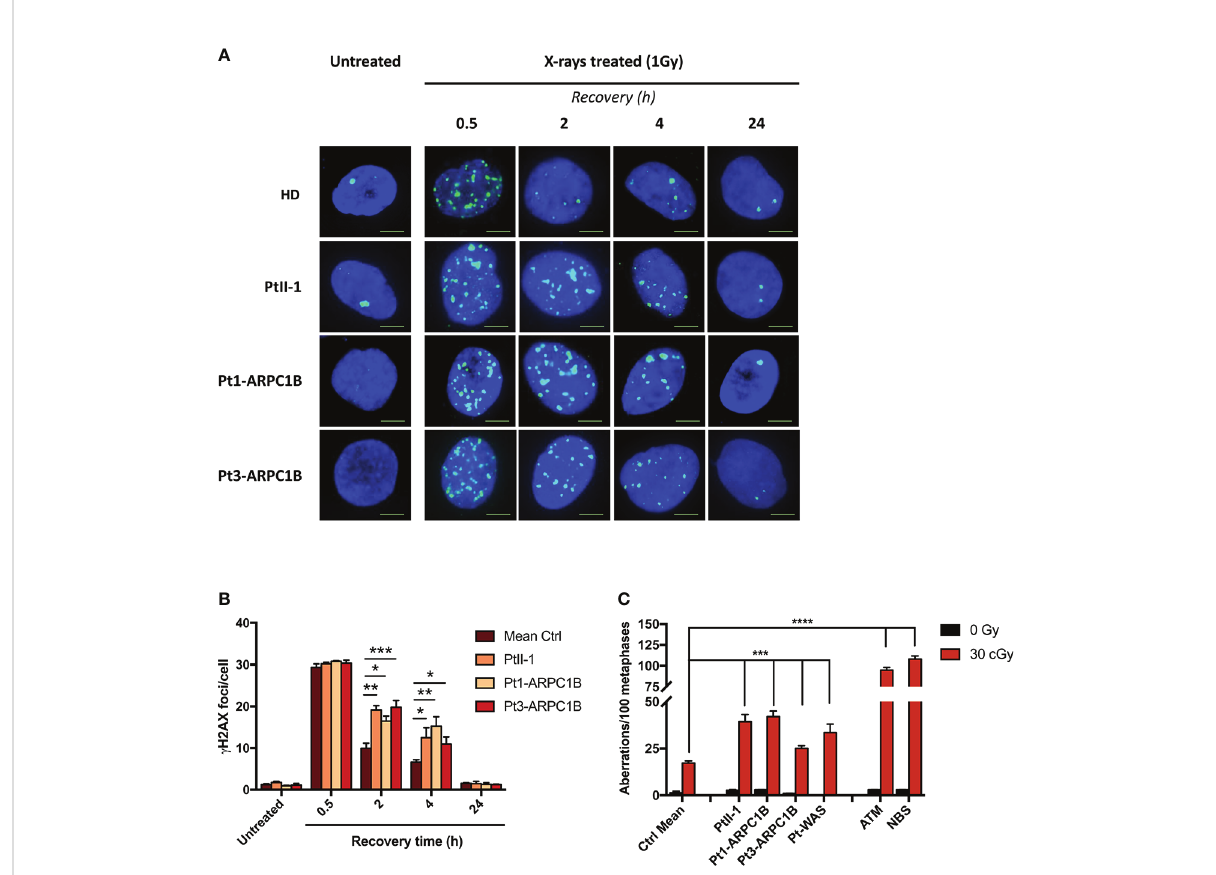
FIGURE 1 DNA DSB repair kinetics in healthy donors (HDs), PtII-1, Pt1-ARPC1B, and Pt3-ARPC1B. (A) Representative images of g H2AX staining in primary fi broblasts from HDs and patients irradiated with 1Gy X-rays and fi xed after 0.5, 2, 4, and 24 h. (B) Histograms showing the number of g H2AX foci/cells in fi broblasts reported as mean ± SEM ( n = 3; HDs = 3) at different time points after irradiation. (C) Frequency (mean ± SEM; n = 3; HDs = 6) of chromatid-type aberrations on irradiated EBVB cells in the G2-cell cycle phase. Statistical analysis was performed with a two-way ANOVA test and Tukey posttest. * p < 0.05; ** p < 0.01; *** p < 0.001; **** p <